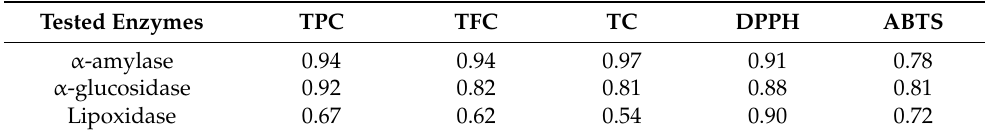
Table 3. The correlation (R 2 ) between enzyme inhibition (%) and bioactive compounds and antioxi- dant power from Ziziphus mauritiana and Balanites aegyptiaca